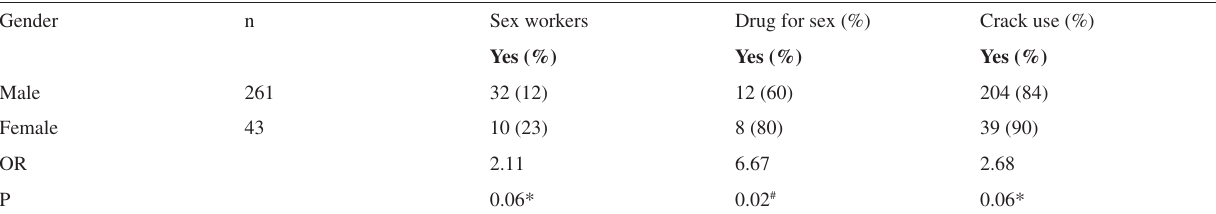
Table 2 - Gender differences of selected risk behaviors from a sample of drug users Gender